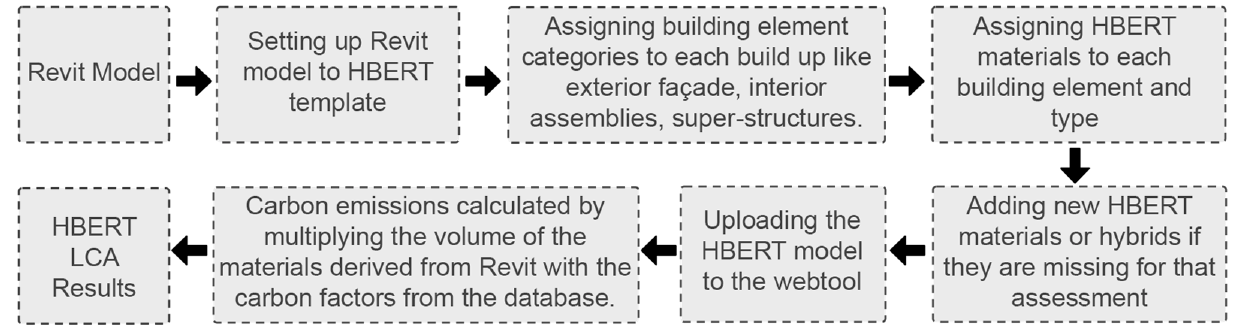
Figure 7. HBERT LCA Calculation Process.